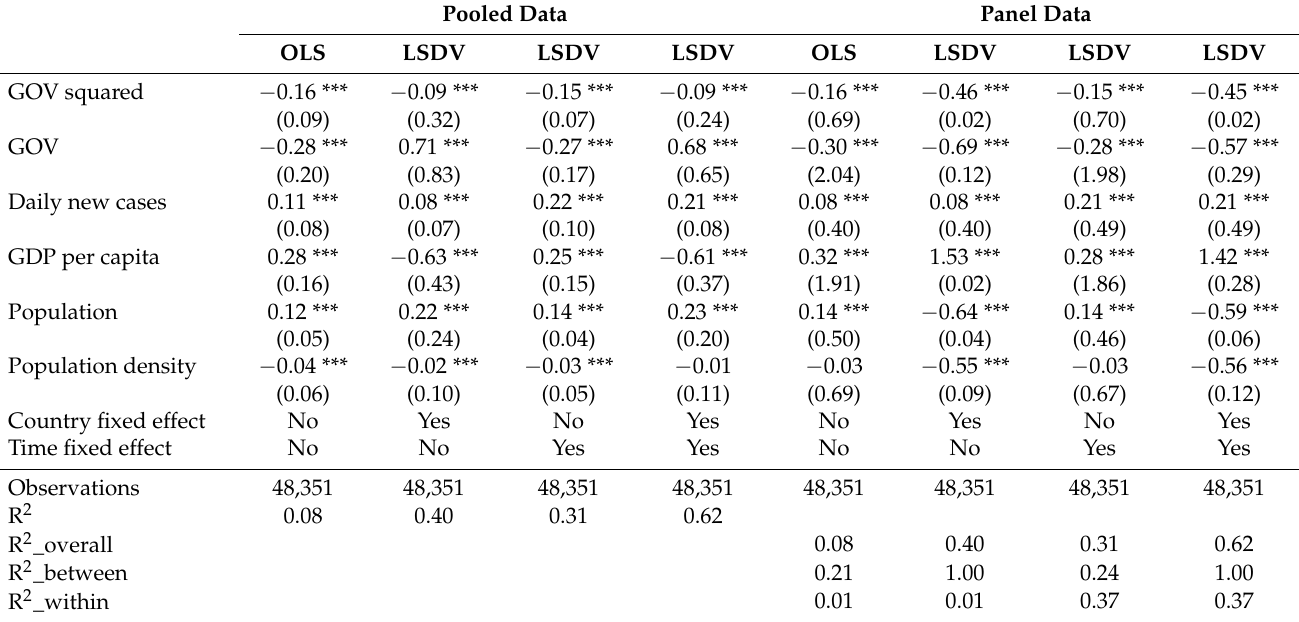
Table 7. Robustness checks: one WGI